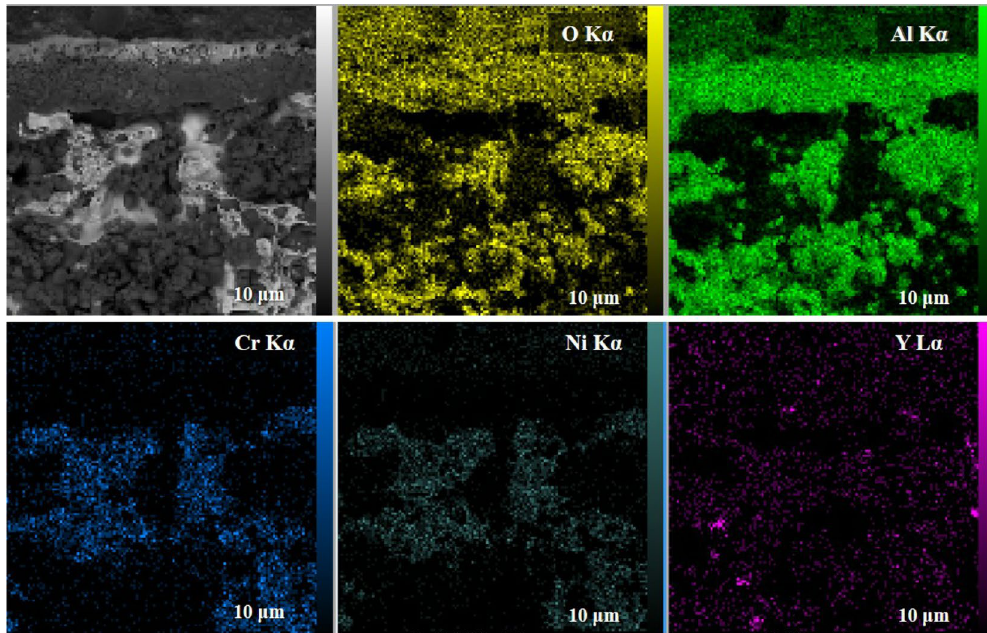
Figure 16. FESEM electron image and EDX elemental mapping for the nanocrystalline MCrAlY coating after long-term exposure at 1000 °C for 1000